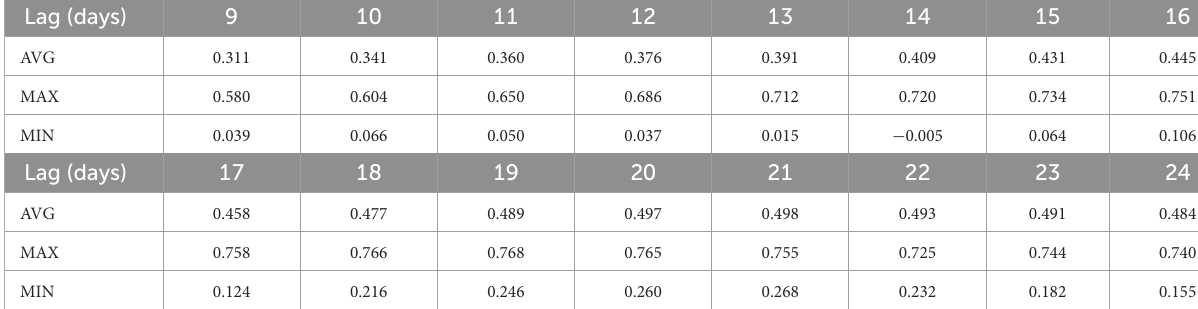
TABLE 3 r -values according to mobility